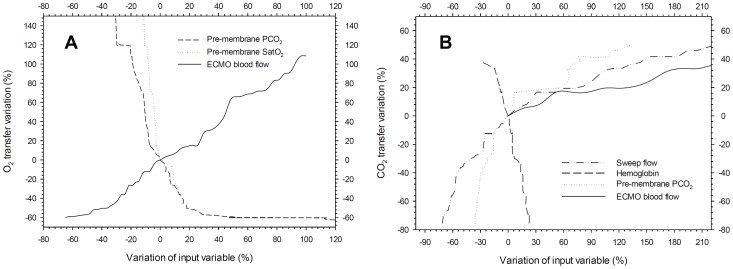
Spider plots showing the strength of association between O2 transfer (Panel A) and the variables extracted from the multivariate analysis and the association between CO2 transfer (Panel B) and the variables extracted from the multivariate analysis.All data were collected from the animals, with and without multiple organ failure. The input variables are shown in the legend.